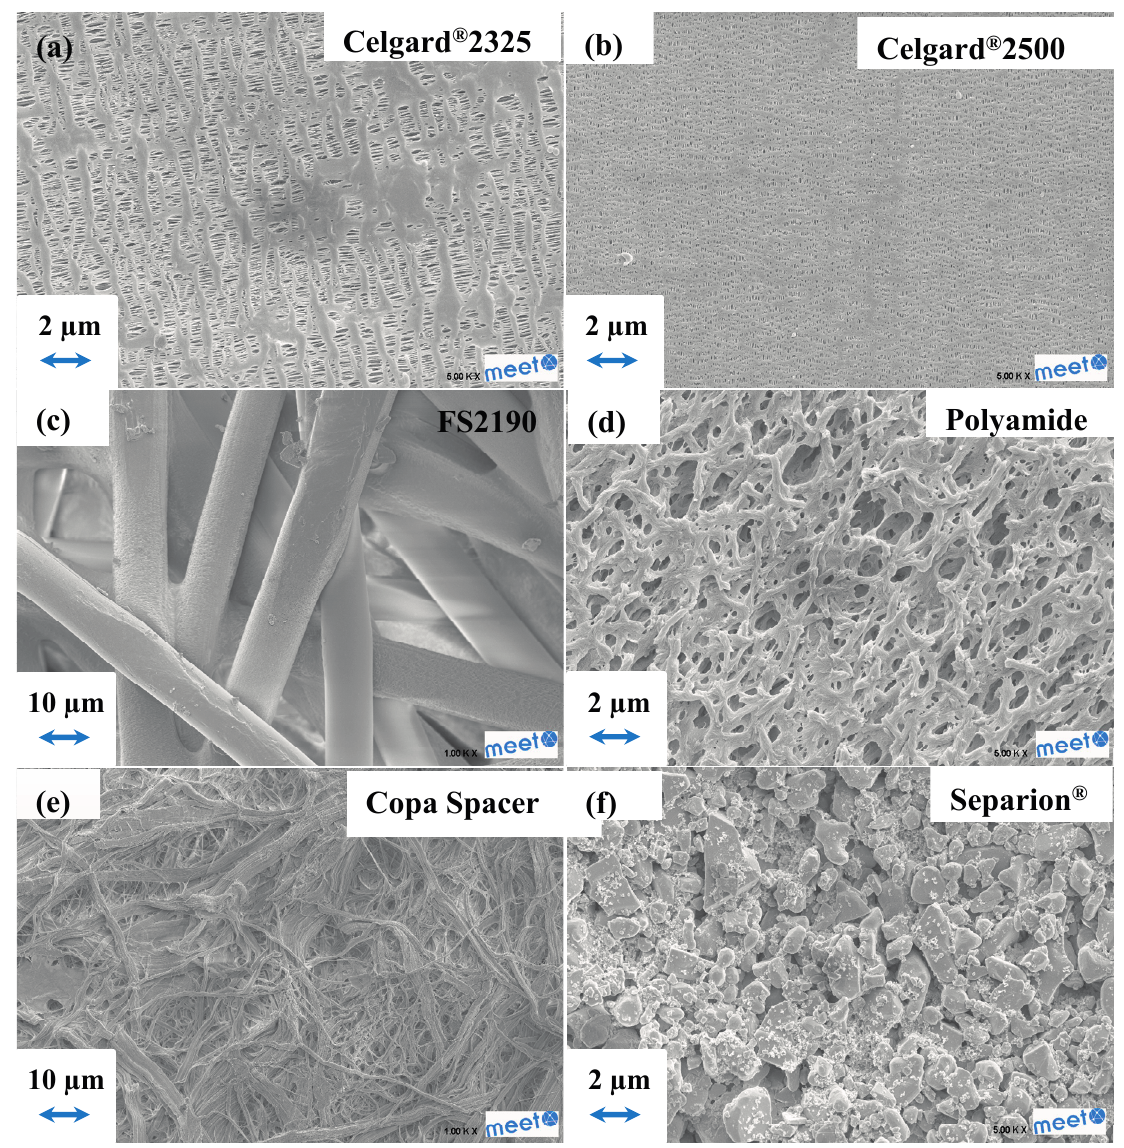
Figure 1. Scanning electron microscopy (SEM) images of ( a ) Celgard ® 2325 (PP/PE/PP); ( b ) Celgard ® 2500 (PP); ( c ) Freudenberg FS2190 (PP); ( d ) Polyamide; ( e ) Copa spacer (cellulose); and ( f ) Separion ®